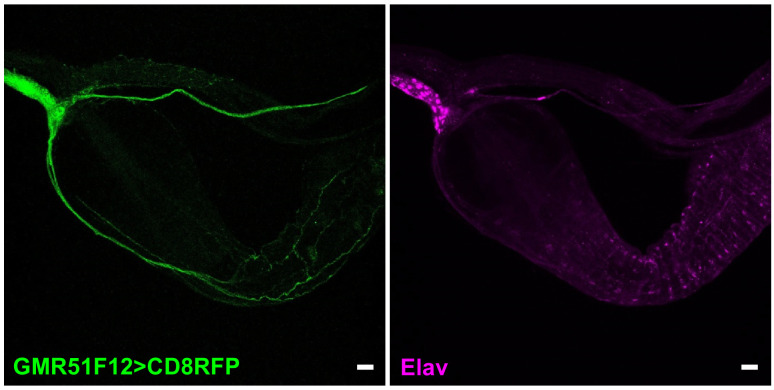
Visualizing gut innervation by neurons labeled in GMR51F12-Gal4 flies.Wholemount immunostaining for RFP (left) and Elav (right) in gut of GMR51F12-Gal4; UAS-CD8RFP flies, scale bars 20 μm.